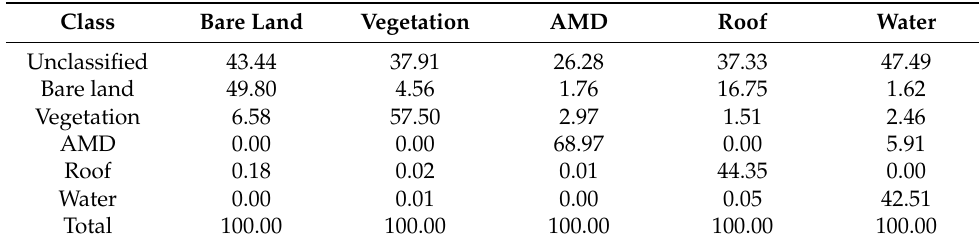
Note: Overall Accuracy = 49.84%. Table 5. The confusion matrix of the U-Net results (%).